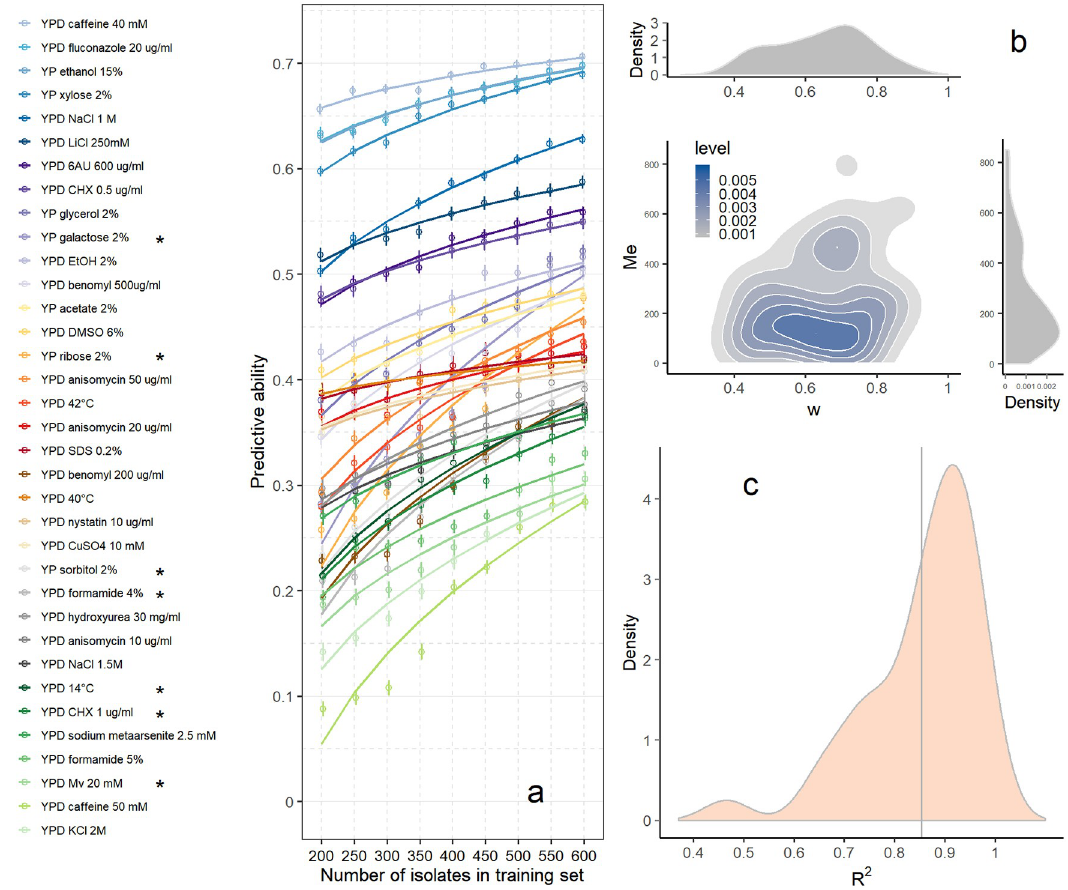
Fig 5. The predictive abilities of ORF-based genomic prediction for 35 traits using different numbers of isolates in training sets. (a) When using different numbers of isolates in training sets between n = 200 and n = 600 in steps of 50 for ORF-based prediction, the predictive abilities of all traits increased as the number of isolates in the training set increased. The solid curves are fitted lines that correspond to the function (2), where r represents the predictive ability in this study (details see text). Traits for which the fitting of the function produced outliers ( ^ r > 1 ) are marked by an asterisk ( � ). (b) The joint distributon of w and Me for 28 traits with ^ r < 1 . (c) The R 2 of the fitting of the function (2) for the 35 traits. The vertical line depicts the mean of the R 2 for the 35